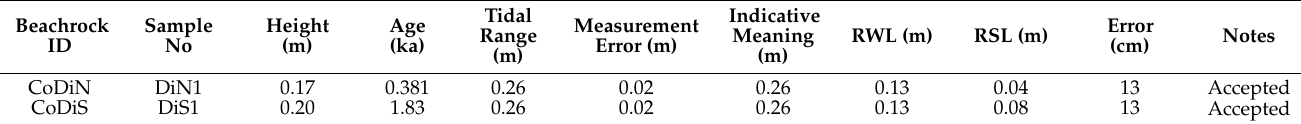
Table 3. Past relative sea level